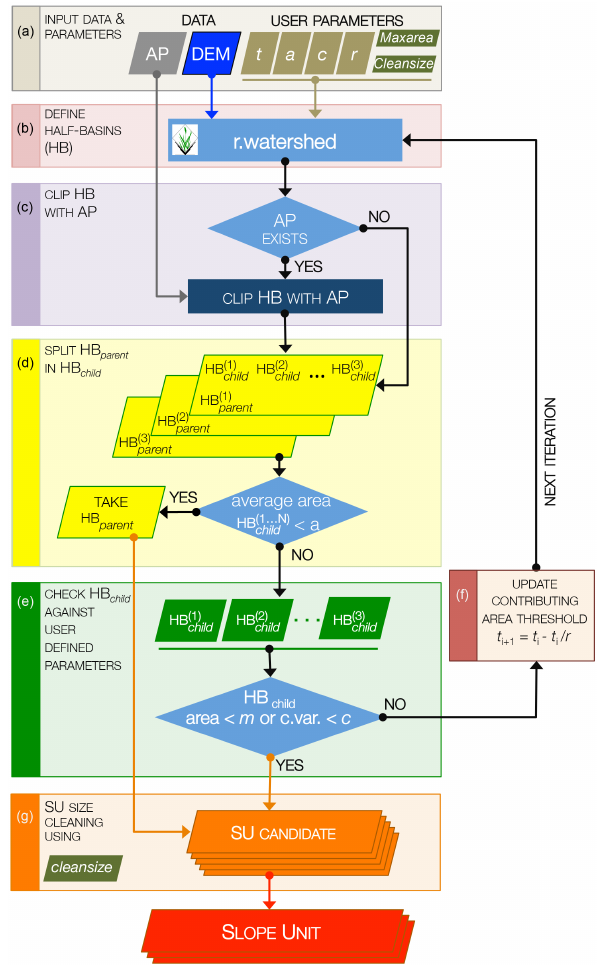
Figure 2. Flowchart for the r.slopeunits software. (a) Input data and parameters. AP, (input parameter name: plainsmap ) map showing plain areas to be excluded from the processing; DEM, ( demmap ) digital elevation model; t , ( thresh ) initial FA thresh- old area; a , ( areamin ) minimum area; c , ( cvmin ) circular vari- ance; r , ( rf ) reduction factor; maxarea , maximum SU area; cleansize , size of candidate SU to be removed; see text for de- tailed explanation. (b) r.watershed processing in GRASS GIS (Neteler and Mitasova, 2007). (c) Tests if the produced HBs are in a plain area. (d) The average area of each new HB child in each HB parent is checked against a . (e) HB child is individually checked against a and c requirements. (f) The process proceeds to iteration i + 1 for each and every HB child that still does not meet the re- quirements, with an updated t i + 1 = t i − t i /r FA threshold. (g) Small polygons are removed from the candidate SU